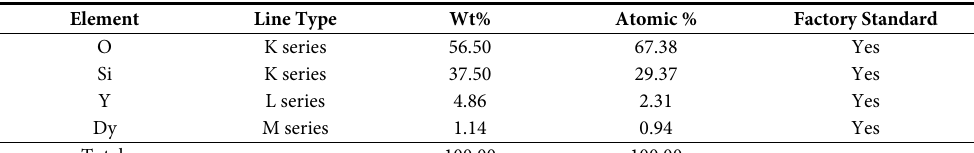
Fig. 3. SEM images of natural diatomite (a), 6% Dy-doped Y Figure 3. SEM images of natural diatomite (a), 6% Dy-doped Y 2 O 3 (b) and 6% Dy-doped Y 2 O 3 - coated diatomite at different magnification (c,d) Table 2. The atomic percent of 6% Dy-doped Y 2 O 3 -coated diatomite.